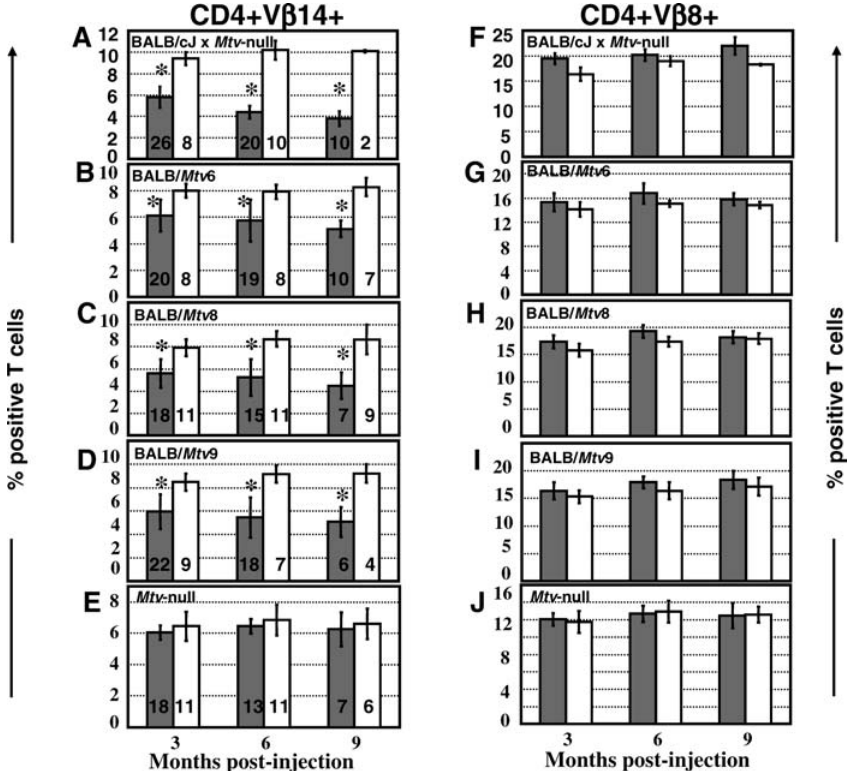
Figure 3. BALB/c X Mtv -Null F1 Hybrids and Mice Carrying Single Mtv Proviruses Exhibit C3H MMTV Sag-Specific T-Cell Deletion PBLs isolated from MMTV-infected (dark bars) and control non-infected (light bars) mice at different times were dually stained with mouse-specific CD4- PE and V b 8 or V b 14-FITC antibodies followed by FACS analysis. The percentages of C3H Sag-reactive CD4 þ V b 14 þ (A–E) and non-reactive CD4 þ V b 8 þ (F– J) T cells obtained from BALB/c X Mtv -null F1 (A and F), BALB/ Mtv6 (B and G), BALB/ Mtv8 (C and H), BALB/ Mtv9 (D and I), and BALB/ Mtv -null (E and J) are depicted. Numbers inside the bars represent numbers of animals tested. The average percentages of T cells in the MMTV-infected Mtv -positive strains (including standard deviation) were significantly different from non-infected controls of the same strains by the two-tailed Student’s t test ( p , 0.05) (asterisks). In contrast, infected Mtv -null animals failed to demonstrate T-cell deletion. PE,